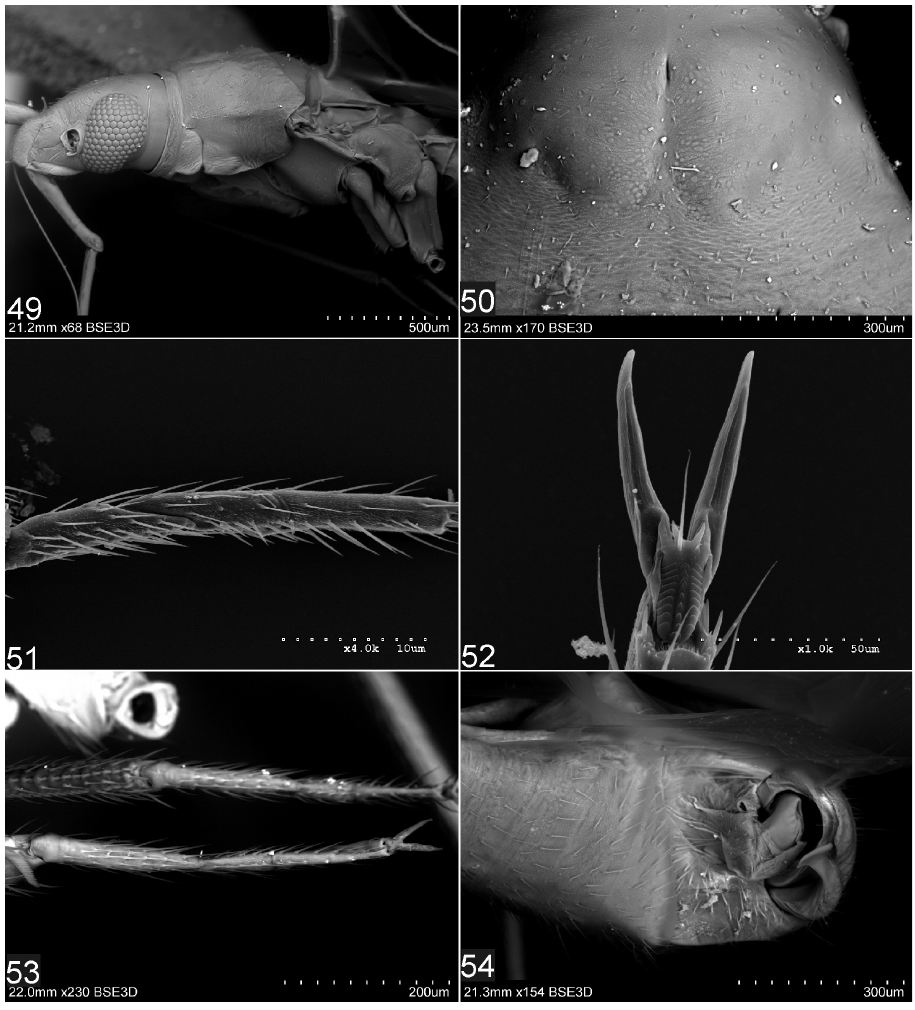
Figures 49–54. Scanning electron micrographs of bisbistillatus group of species of the genus Fulvius : F. imbecilis ( 49–52 ), F. slateri ( 53 ): 49 Head and pronotum (left lateral view) 50 Structure and vestiture of pronotum 51, 53 Metatarsus 52 . Pretarsal claw 54 Male